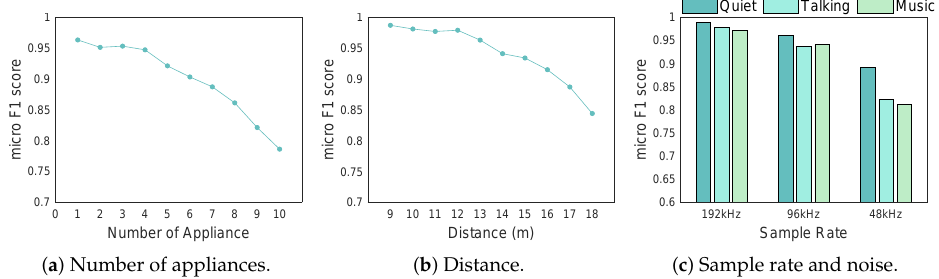
( c ) Sample rate and noise.